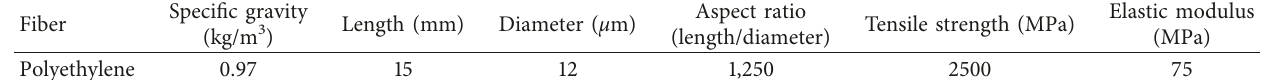
Table 3: Mechanical properties of polyethylene